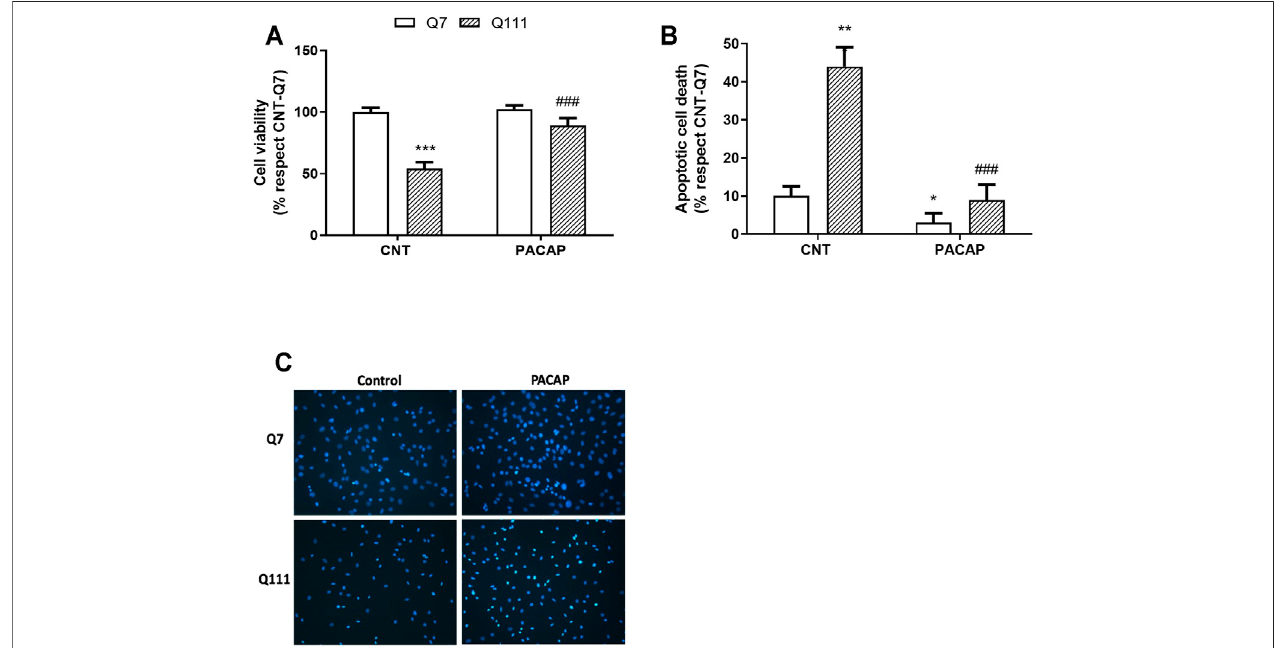
FIGURE 2 | PACAP promotes cell viability in STHdhQ111/Q111 cells. STHdhQ7/Q7 (Q7) and STHdhQ111/Q111 (Q111) cells were treated with PBS (CNT) or PACAP (10 − 7 M) for 24 h. (A) Cell survival was analyzed by the MTT assay. Dataare expressed as percentage respect to CNT-Q7 cells and results are the mean ± SEM ( n (cid:1) 4). (B) Apoptotic nuclei were counted using the Hoechst 33,258 staining. Results are expressed as the mean ± SEM ( n (cid:1) 4) of apoptotic nuclei with respect to the totalnucleiinCNT-Q7 cells. (C) RepresentativeimagesofHoechst33,258stainingareshown.Scalebar20 µm.Inallcases,datawereanalyzedbyusingtwo-way ANOVA followed by Tukey as a post-hoc test. * p < 0.05, ** p < 0.01, and *** p < 0.001 as compared to CNT-Q7 cells; ### p < 0.001 as compared to CNT-Q111